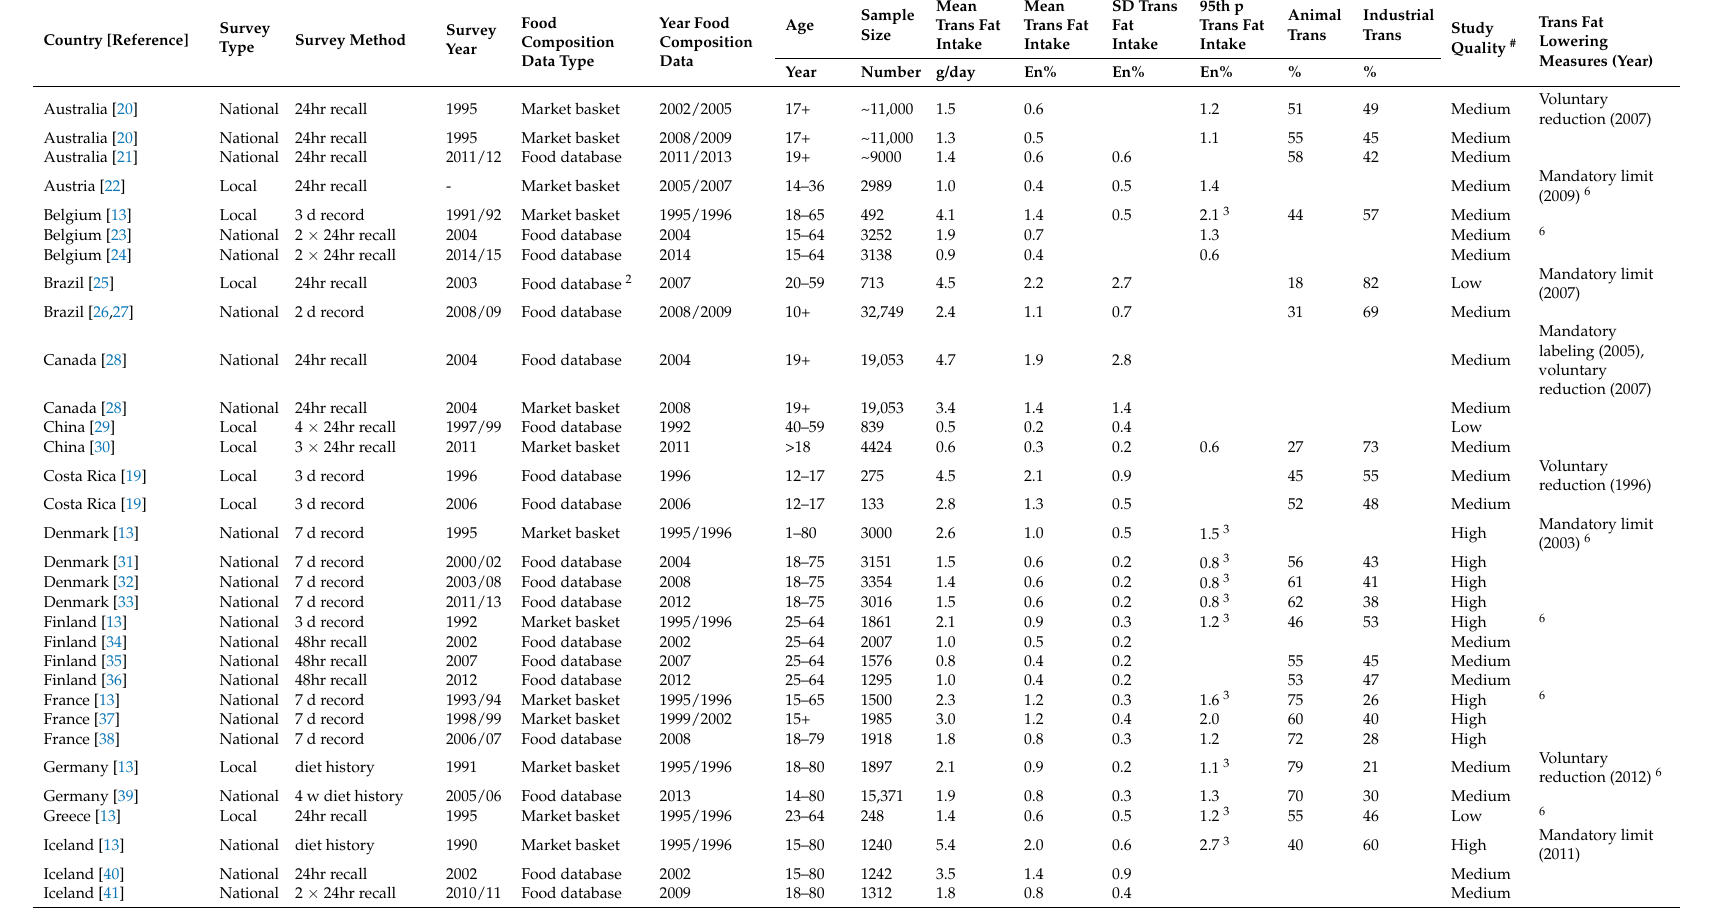
Table 1. Mean intakes of trans fat and its dietary sources in populations from 29